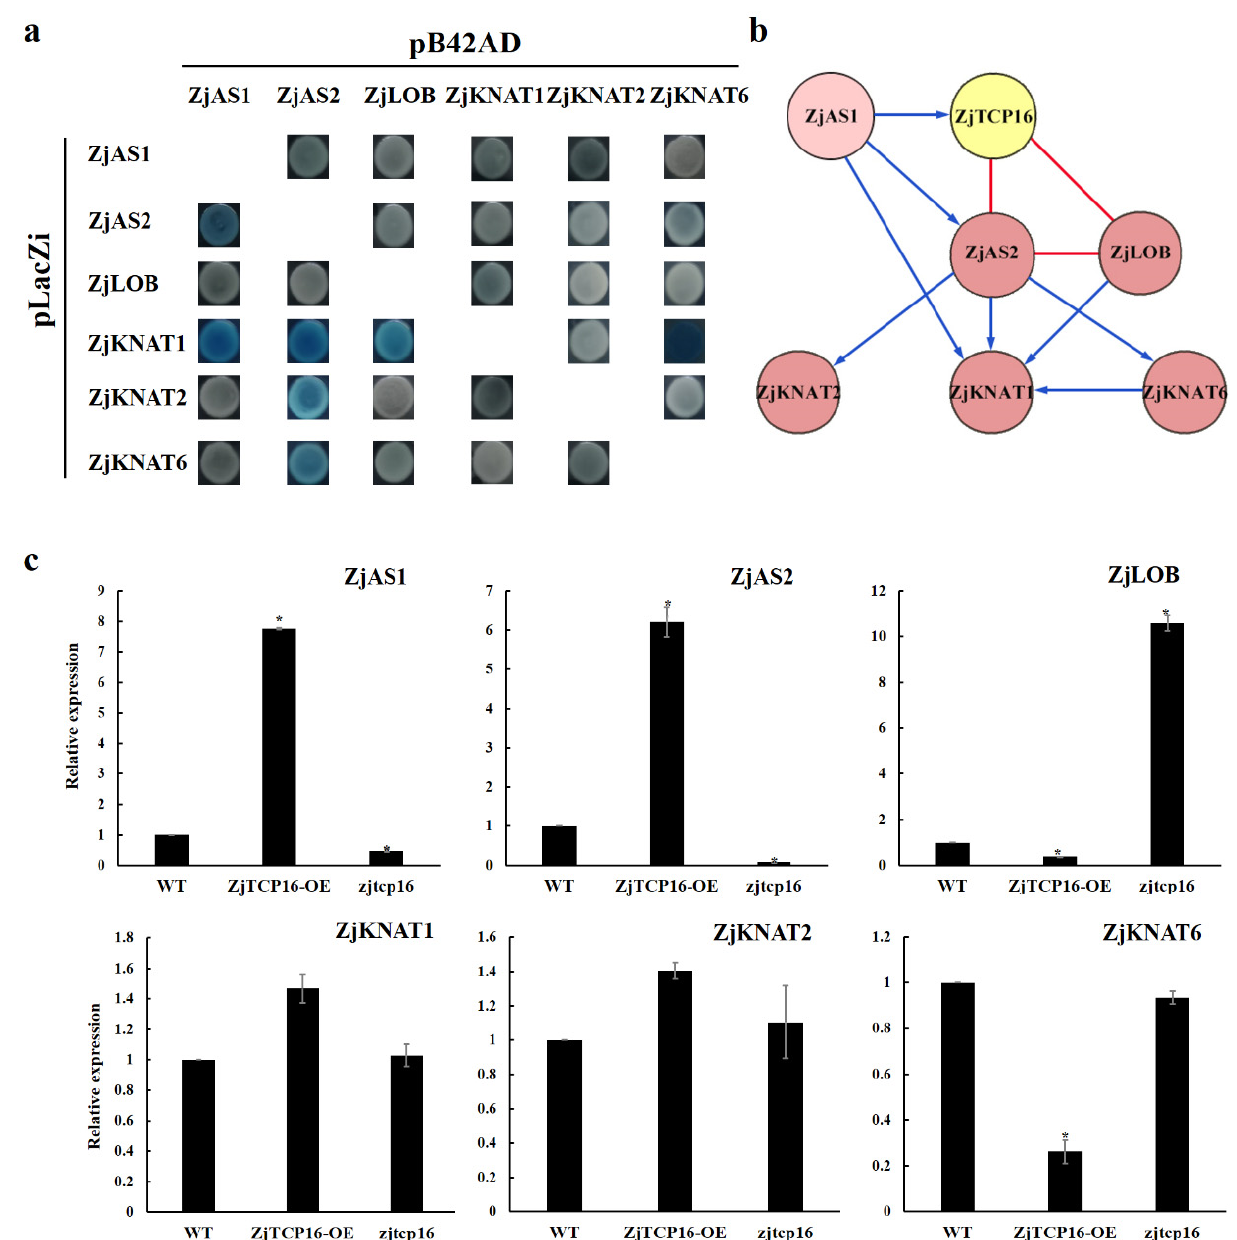
Figure 7. ZjTCP16 affected the expression of genes involved in morphogenesis and cell proliferation through the ZjAS2 and ZjLOB pathway. ( a ): Yeast one-hybrid (Y1H) assays of ZjAS2 and ZjLOB and their potential downstream genes. ( b ): Interaction network of genes involved in plant morphogenesis mediated by ZjTCP16. ( c ): Expression of genes involved in morphogenesis and cell proliferation in ZjTCP16 -OE and zjtcp16 mutant jujube shoots. Bars represent the mean ± standard deviation of 9 plants. Asterisks indicate significant differences compared with WT (*: p < 0.05; one-way analysis of variance (ANOVA)).